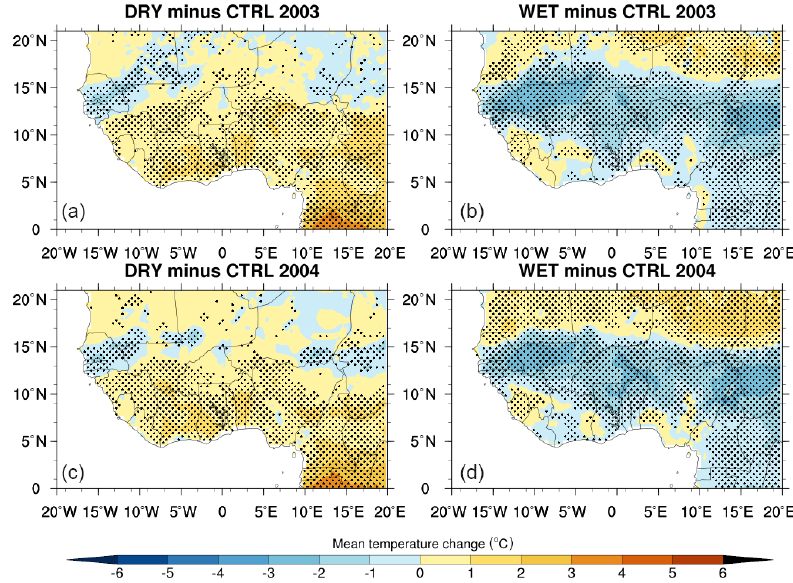
Figure 12. Changes in 2m temperature ( ◦ C) for JJAS 2003 and JJAS 2004 from dry ( a and c , respectively) and wet ( b and d , respectively) experiments with respect to the control experiment; the dotted area shows differences that are statistically significant at the 0.05 level.